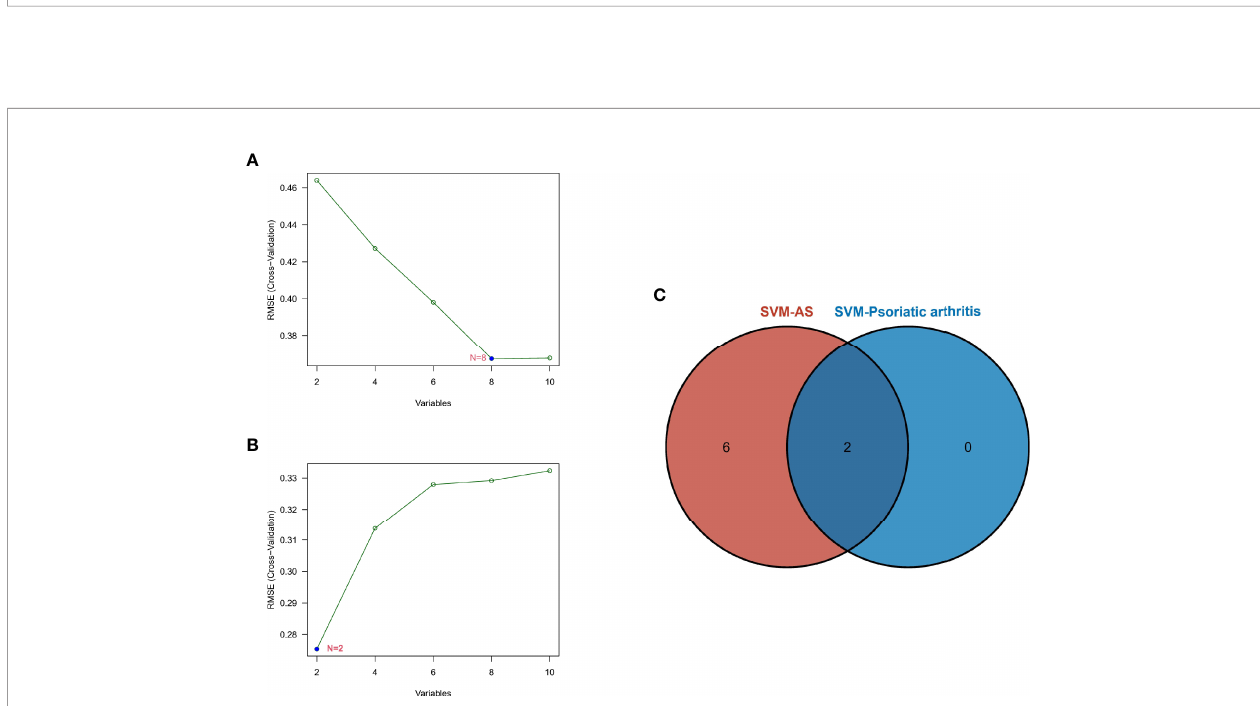
FIGURE 5 | (A) SVM-RFE algorithm to screen diagnostic markers in the GSE25101 database. (B) SVM-RFE algorithm to screen diagnostic markers in the GSE61281 database. (C) Venn diagram shows the optimal diagnostic